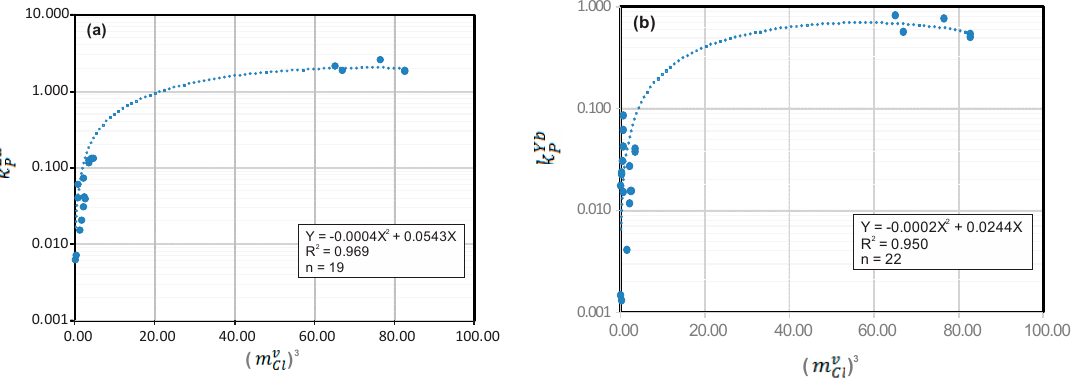
Figure 1. Plot of REE fluid–granitic melt partition coe ffi cient ( k REE ) versus Cl molality ( m v ) of magmatic fluid phase: ( a ) k La versus ( m v ) 3 , and ( b ) k Yb versus ( m v ) 3 . Data used for this plot are from [1–3] (Supplementary Table S1). In each of the equations, Y denotes k REE ; X represents ( m v ) 3 , except for